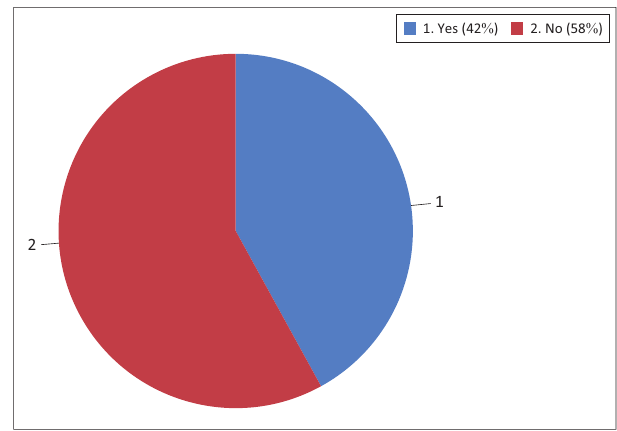
FIGURE 1: Pie graph representing proportion of sampled patients diagnosed with progressive diabetic retinopathy (42 % ) at the Vision 4 Life clinic, eThekwini, between March and December TABLE 1: Distribution of age, gender, ethnicity and duration of diabetes of the sampled study population and diabetic retinopathy patients consulted at the Vision 4 Life clinic, eThekwini, between March and December 2017. Variables